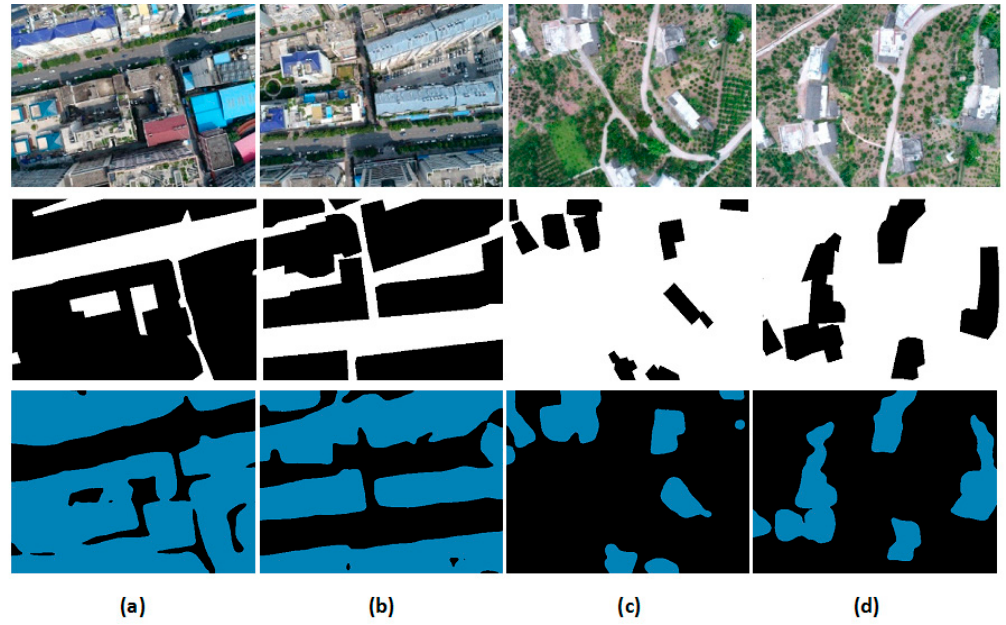
Figure 6. Visual segmentation results on two testing sets which consist of input RGB image (top), reference data (middle), and building extraction result (bottom). ( a ) and ( b ) are from testing area (area_1); ( c ) and ( d ) are from tesing area (area_2).